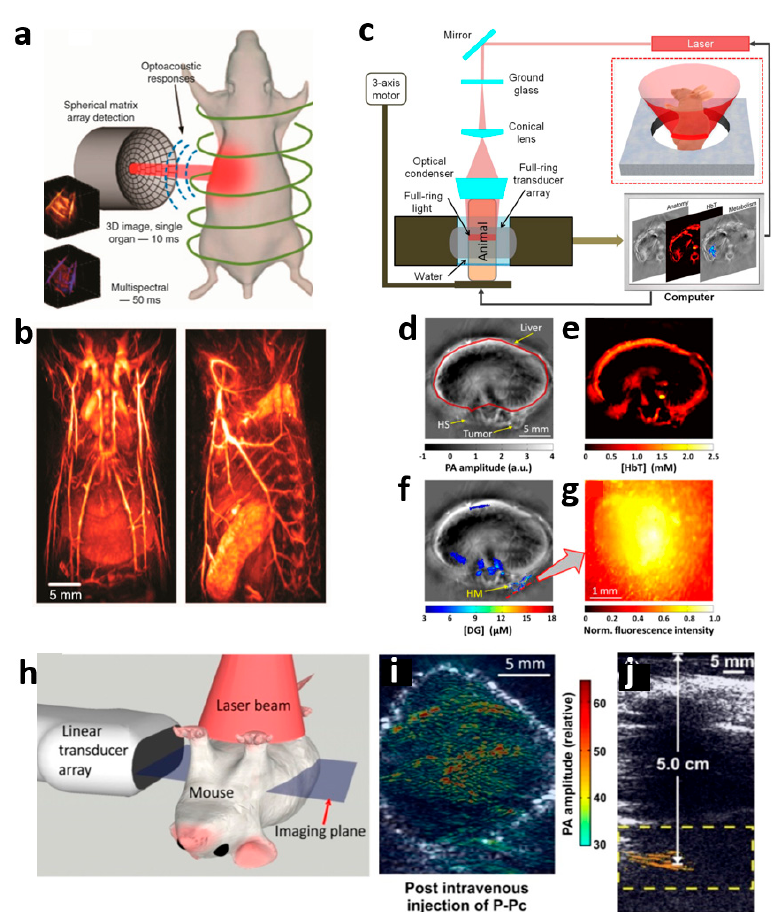
Figure 4. Deep-tissue PAT systems. ( a ) Schematic of spiral volumetric photoacoustic computed tomography (SV-PACT). ( b ) 3D whole body mouse SV-PACT image with high spatial resolution. ( c ) Schematic of ring-shaped confocal PACT (RC-PACT). ( d ) Anatomical RC-PACT image of mouse at 776 nm. ( e ) RC-PACT image of hemoglobin (HbT) concentration. ( f ) PACT image and ( g ) Florescence image of IRDye800-2DG concertation in tumor. ( h – j ) Deep PAI and USI images of the tumor and human arm with phosphorous phthalocyanine (P-Pc) formulation, respectively. Reprinted with